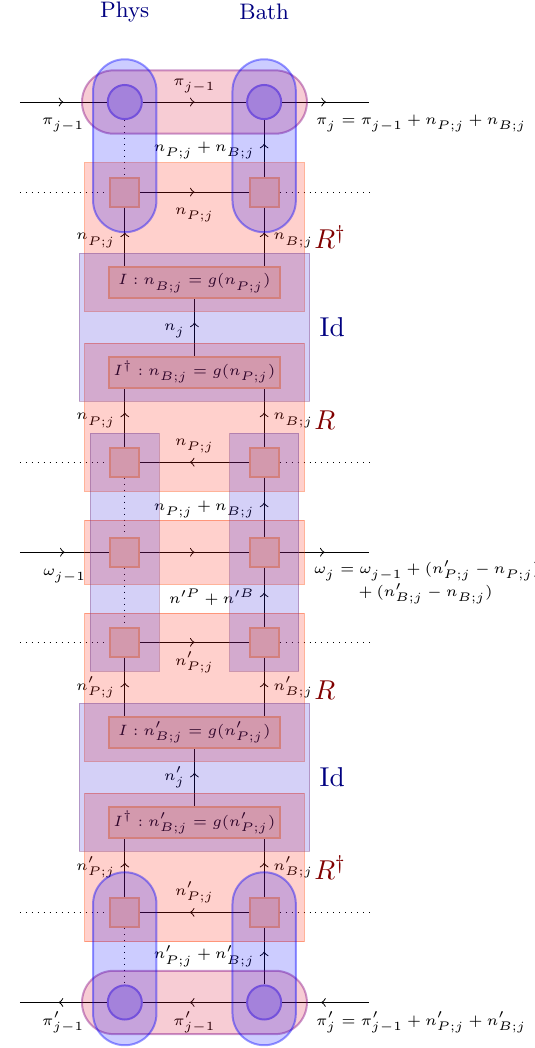
Figure 12: A tensor network representing a single site consisting of an MPS, an MPO, and the adjoint MPS. All tensors are split into several (virtual) objects in order to be rejoined to the tensors used in the LBO (ppDMRG) as highlighted by the red (blue) boxes that contain virtual objects. Note that equivalent bond labels do not indicate the same objects, but only an implicit δ between the, for brevity not shown, different